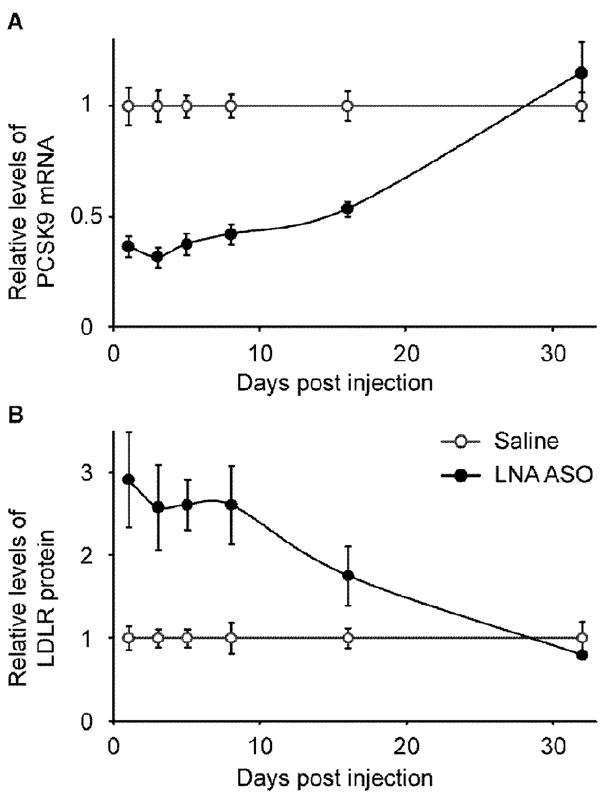
Figure 8. Duration of action after a single i.v. injection in mice. A single injection of 20 mg/kg LNA ASO generated a significant reduction of PCSK9 mRNA lasting for more than two weeks ( A ), with concomitant increase in LDLR protein ( B ). Levels were normalized at day 32. (Mean and SEM, n=4–5).